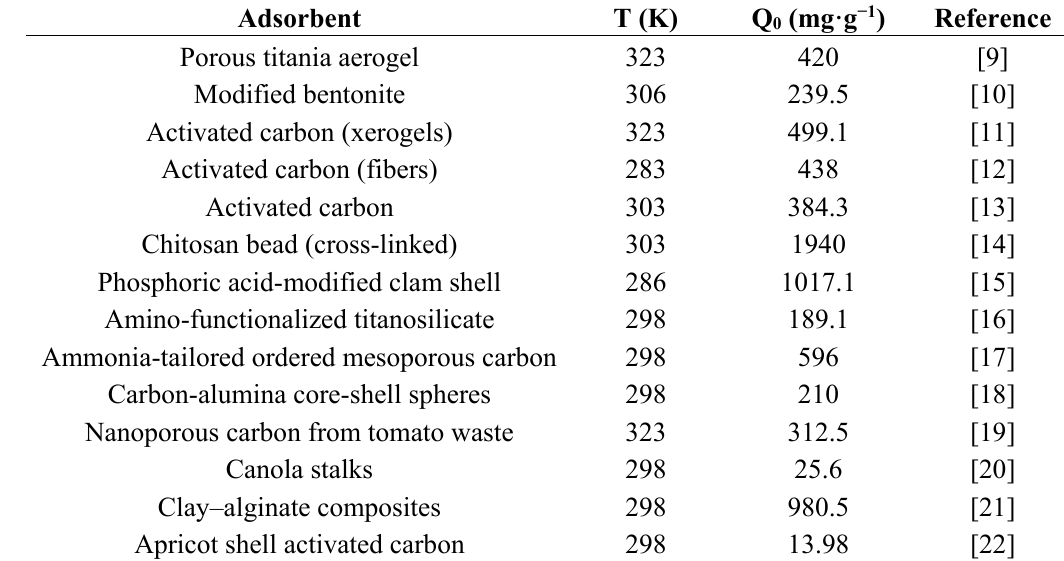
Table 1. Comparison of the maximum monolayer adsorption capacities of azo-dye Orange II onto various